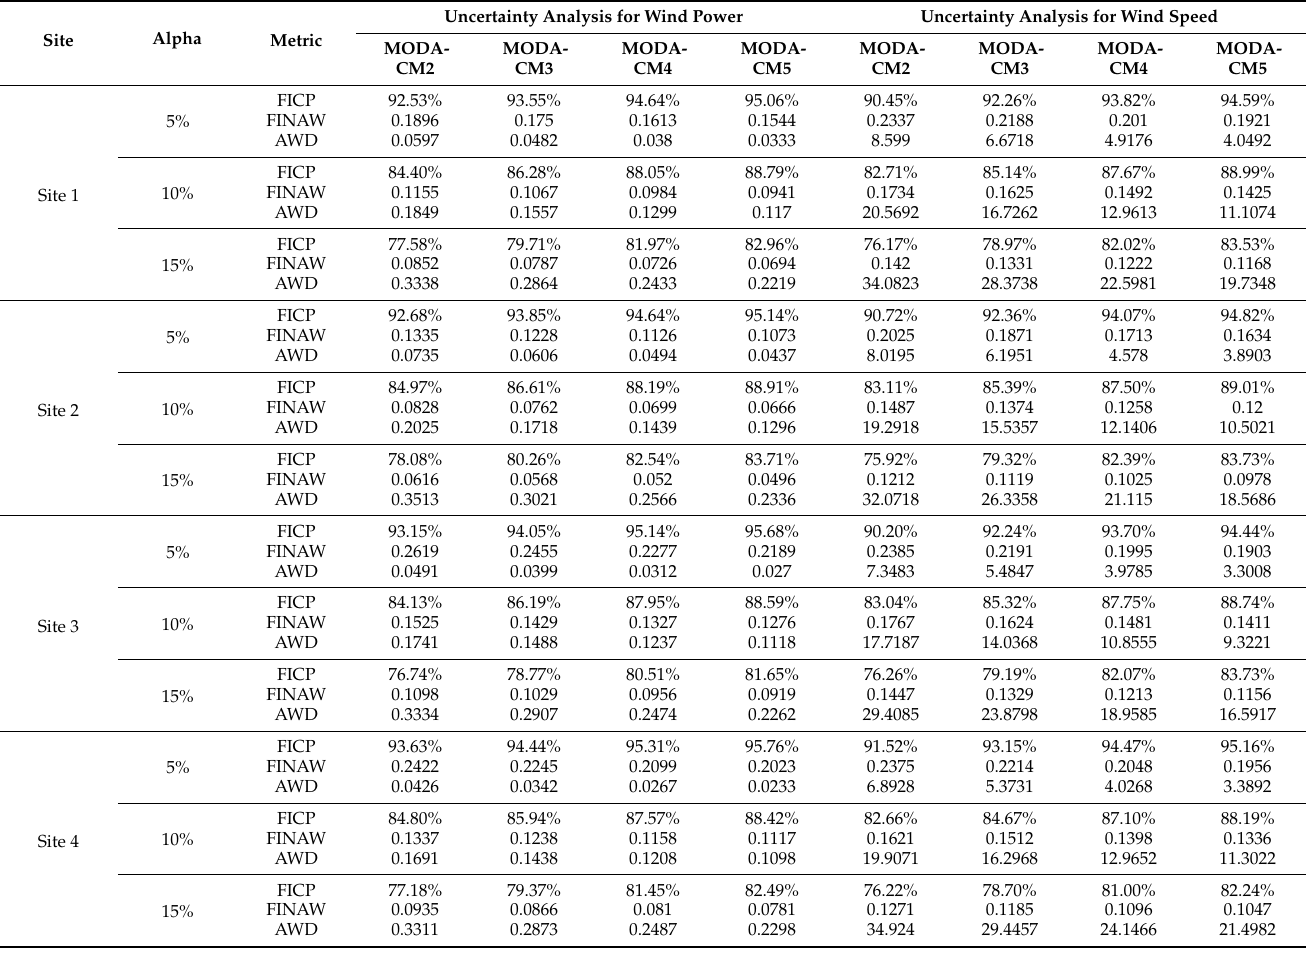
Table 11. Uncertainty forecasting Performance Comparison Table of the Proposed Model and Several Competitive Models from Experiment